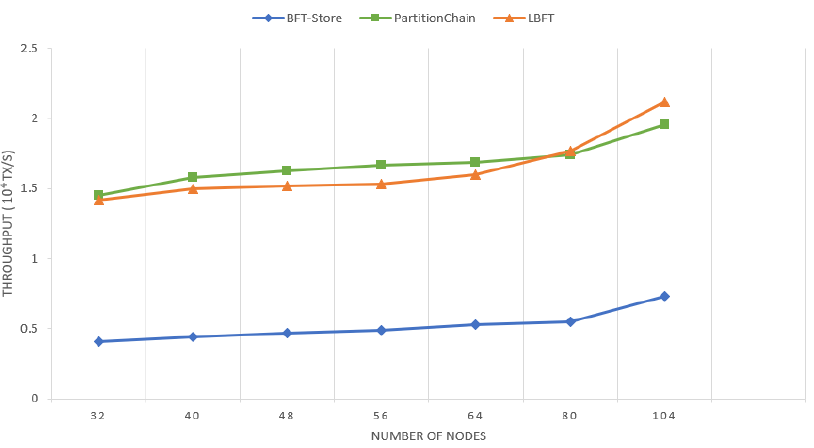
Figure 7. The system throughput of LBFT, PartitionChain, and BFT-Store against the number of